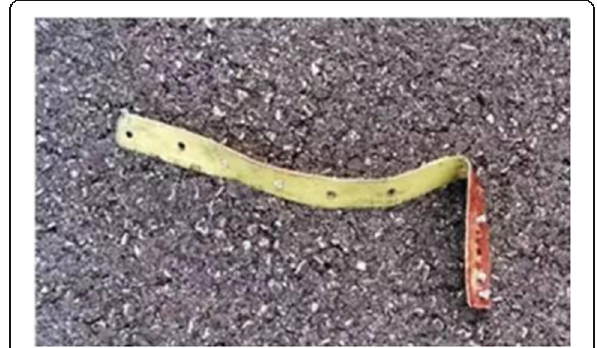
Fig. 1 The twisted metal strip that caused Air France Flight 4590 to crash